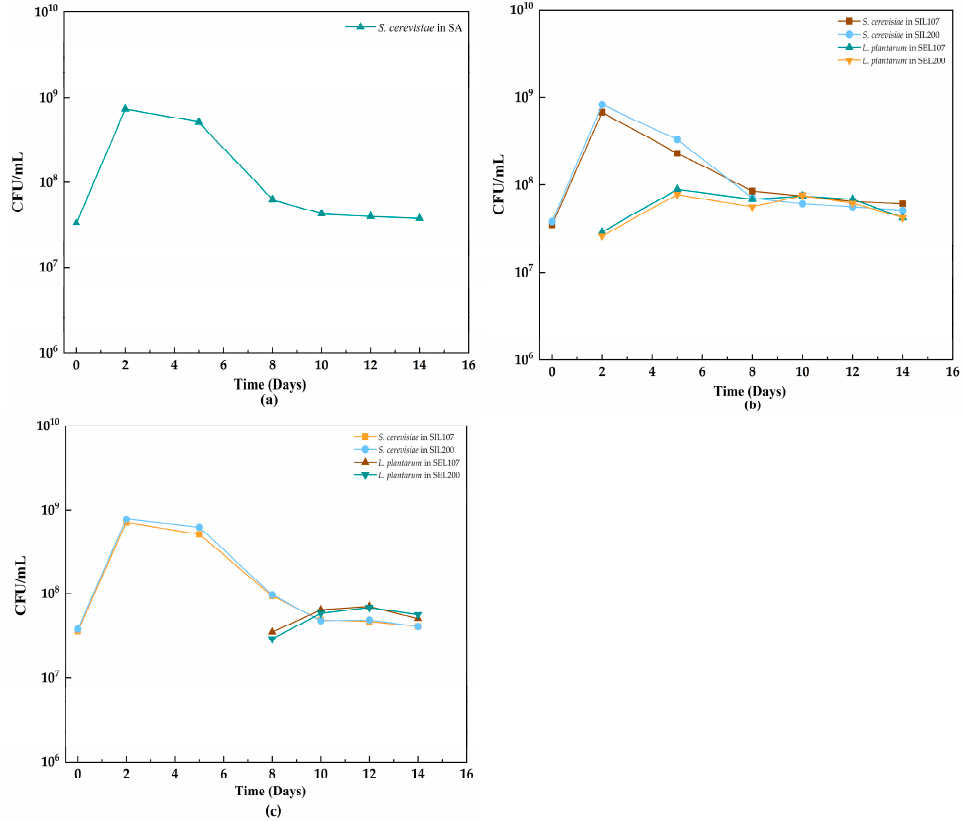
Figure 2. Dynamic changes in the total numbers of S. cerevisiae and L. plantarum in single inocula- tion mode ( a ), simultaneous inoculation mode ( b ), and sequential inoculation mode ( c ) during apple cider fermentation.